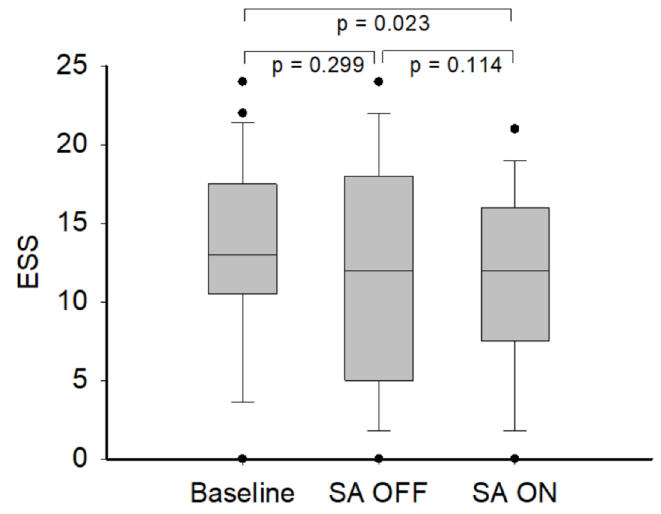
Figure 2. Comparison of baseline, SA OFF, and SA ON in ESS ( n = 25). The horizontal line is the median, box is the IQR and whiskers are the 95% range. p values were from Wilcoxon sign-rank test. The ESS when the SA was on were significantly lower than baseline. ESS = Epworth sleepiness scale, SA = SensAwake TM , IQR = interquartile